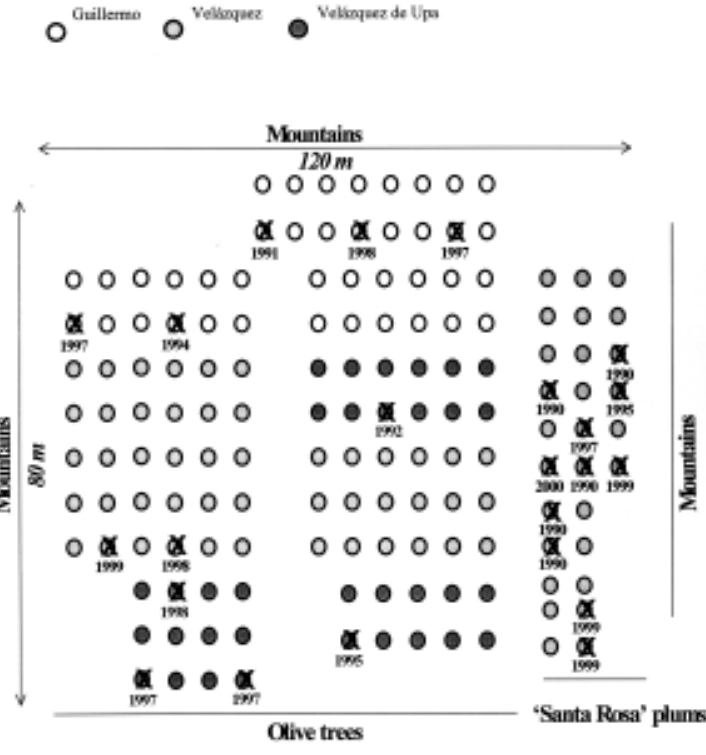
Fig. 1. Spatial and temporal distribution of diseased trees in the orchard studied. The year of removal is shown below each symptomatic and therefore removed tree ( (cid:1)